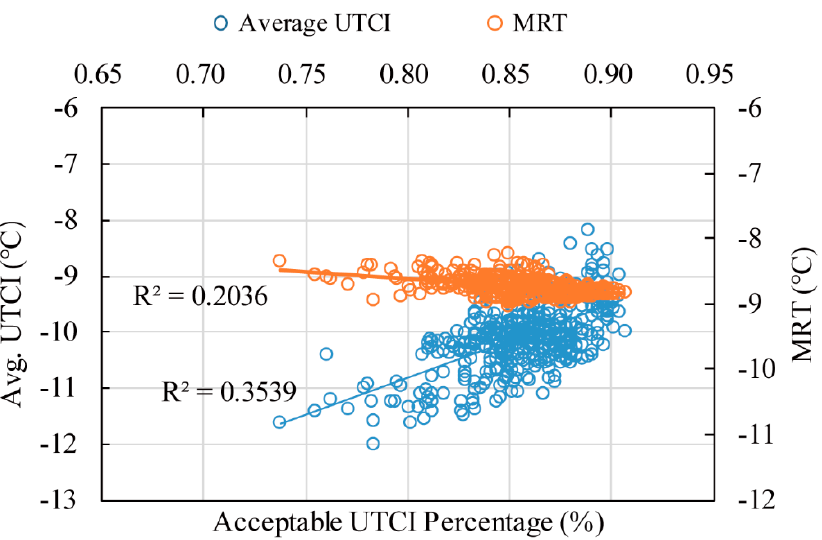
Figure 19. Correlation results of average UTCI, MRT, and acceptable UTCI percentage at street level.